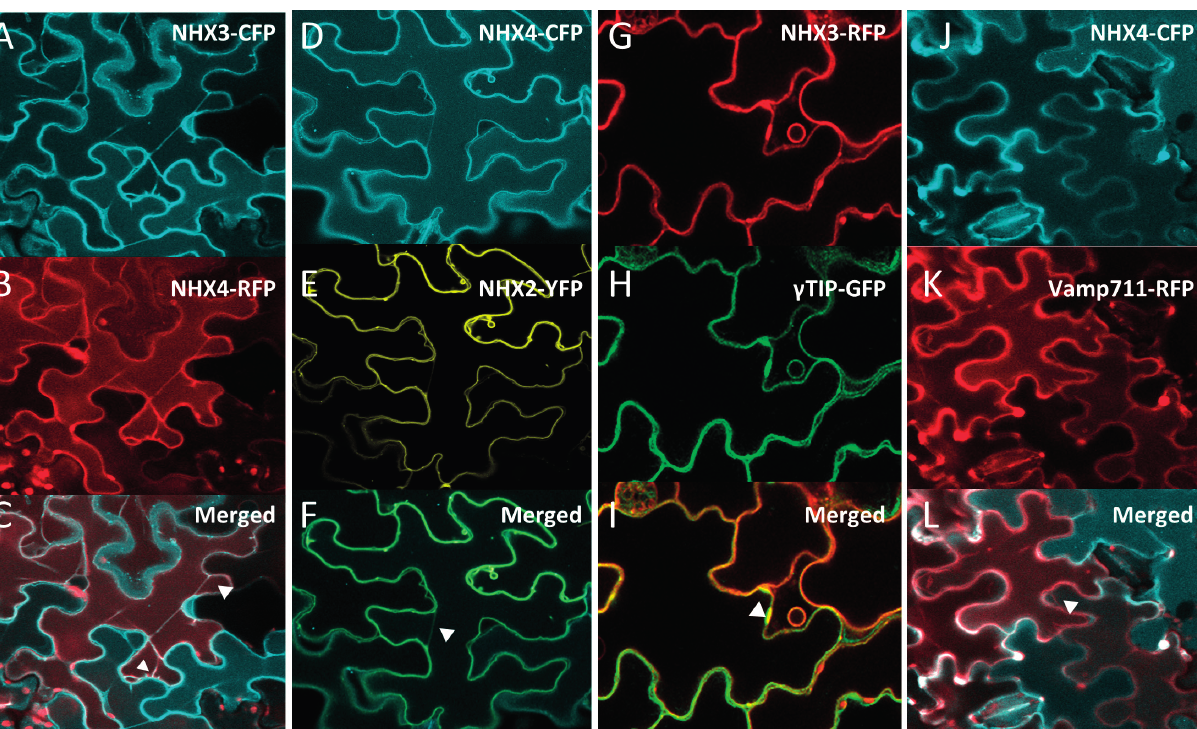
Figure 1. Intracellular localization of NHX3 and NHX4 . Transient co-expression, in Arabidopsis cotyledon epidermal cells, of 35S::NHX3-CFP ( A ) with 35S::NHX4-RFP ( B ) colocalized as shown in the merge fluorescent panel ( C ). Transient expression